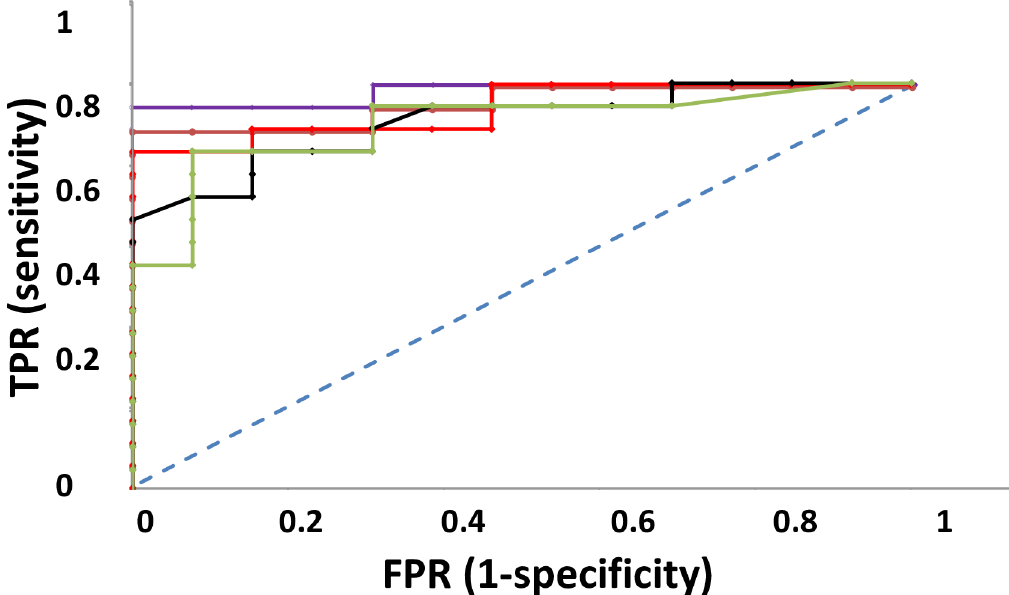
Fig 8. Receiveroperating characteristic (ROC) curve as a tool for prognosis of complications in B . canis- caused babesiosis and cut-off values. ROC plot showing c urvescorresponding to individualcytokine values and linear combinations of different cytokine clusters for uncomplicated vs. complicatedcases. MCP-1 (black), IL-7 (green), LC1 = KC-Like+IL-7+2MCP-1(red), LC2 = KC-Like+2IL-7+2MCP-1 (orange),LC3 = GM-CSF+KC-Like+2IL-7 +2MCP-1(violet).